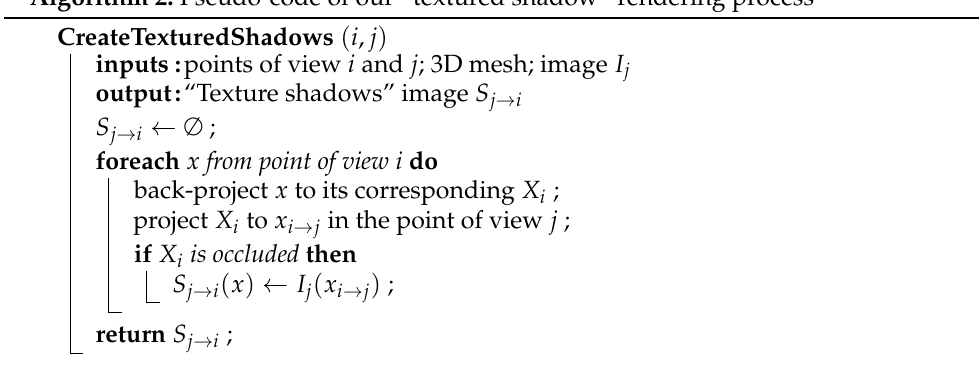
Algorithm 2: Pseudo-code of our “textured shadow” rendering